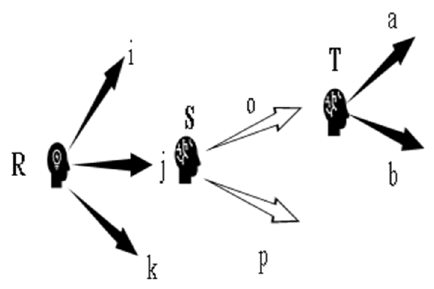
Figure 3. Extensive-form game model tree.